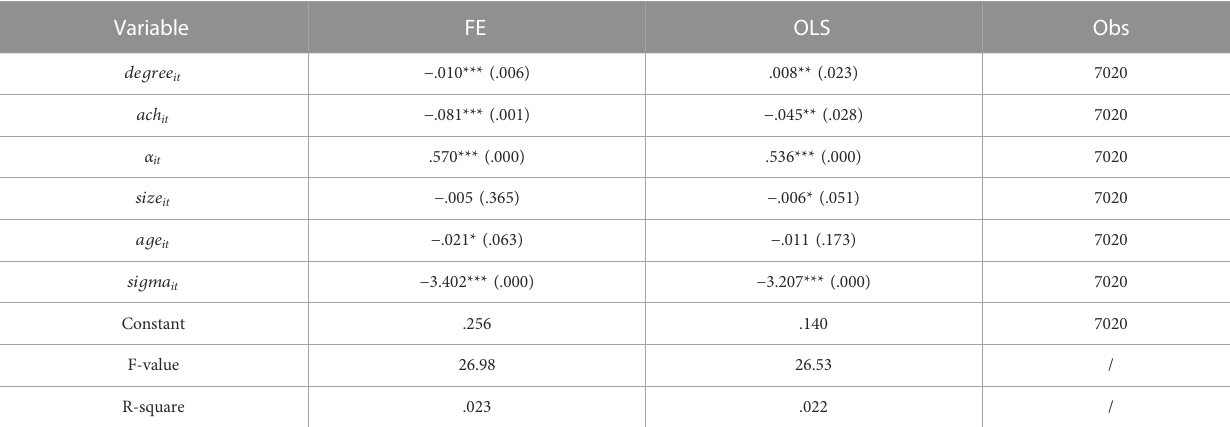
TABLE 6 Regression results of the FE model and